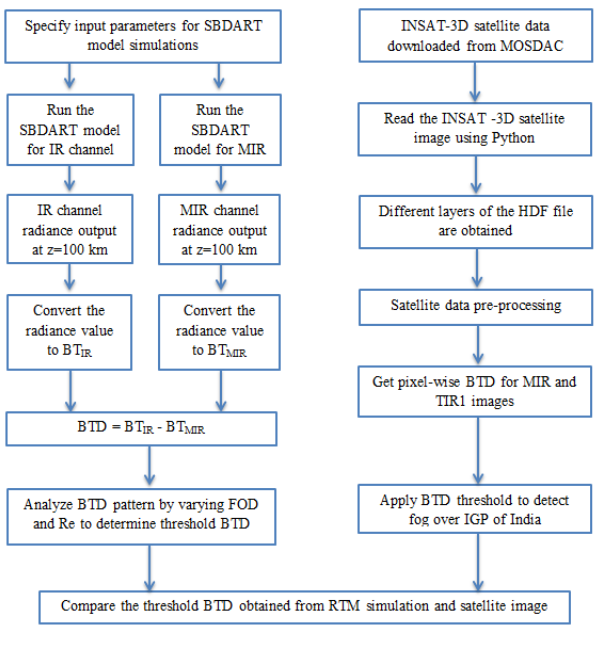
Figure 2. Flowchart depicting study methodology